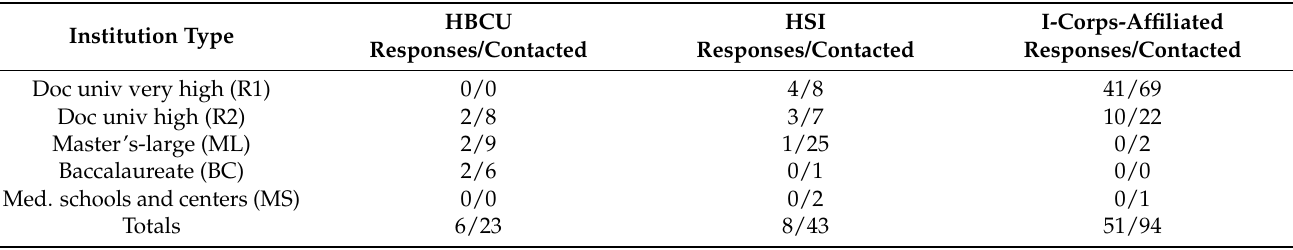
Table 2. Number and type of institution recognized as Historically Black Colleges & Universities (HBCU), Hispanic Serving institutions (HSI), and/or I-Corps affiliated institutions that were contacted and responded ( n = 18 duplicate responses from I-CORP affiliates and n = 2 from